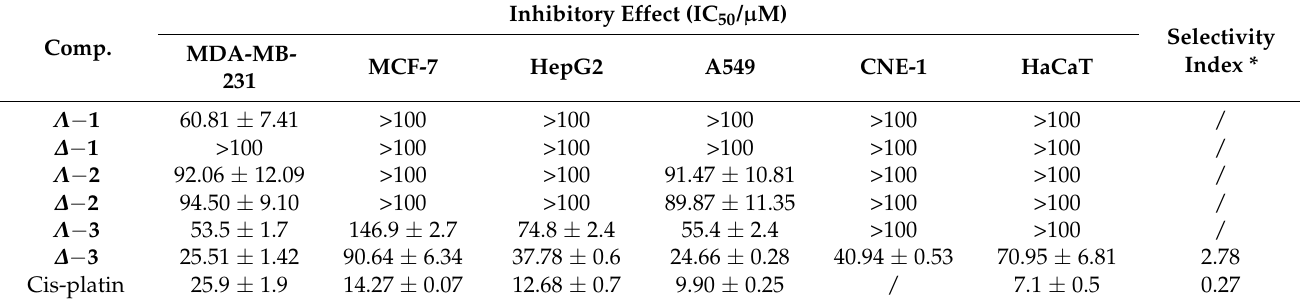
Table 1. Inhibitory effect (IC 50 / µ M) of chiral DPPZ-based Ru(II) complexes and cis-platin against various human tumor and normal cell